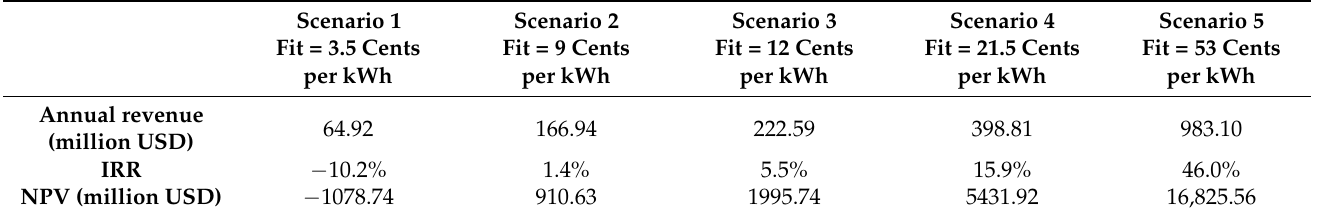
Table 5. Financial analysis of wind power to meet 5% of total electricity demand in six provinces with high wind potentials for PPA of 20 years and different FiT scenarios.